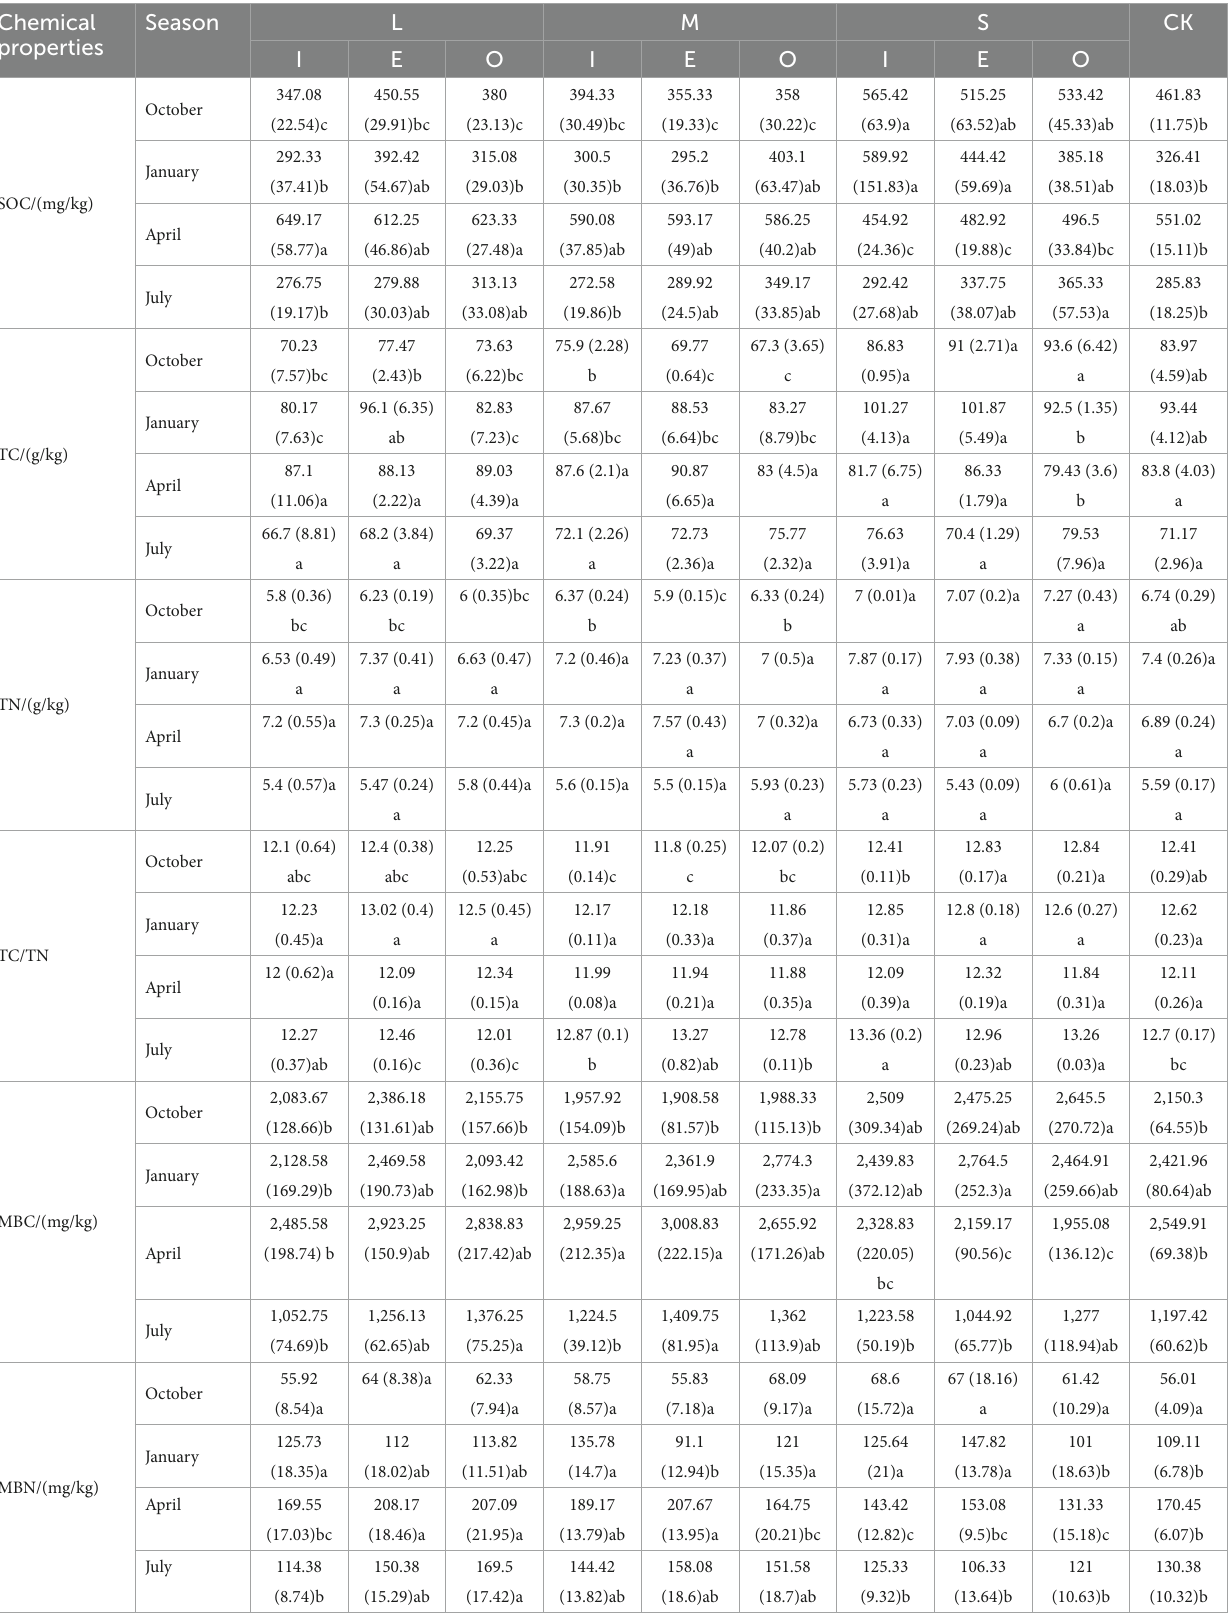
TABLE 1 Summary of soil chemical properties, MBC and MBN of samples from large-gap, medium-gap, small-gap, and control plots. Chemical